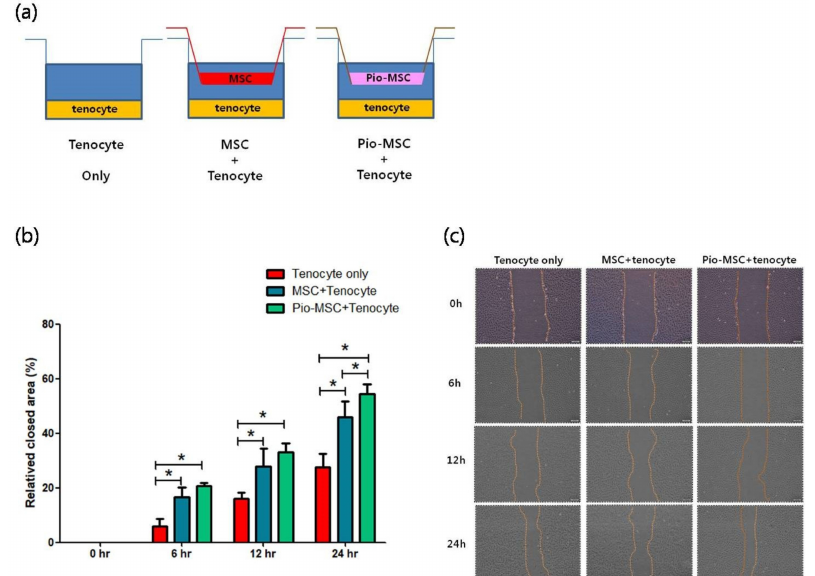
Figure 4. Migration assay of tenocytes following indirect co-culture with MSCs or Pio-MSCs. ( a ) Schematic model of the co-culture system used. Tenocytes were co-cultured with a tenocyte control, and with MSCs and pio-MSCs using transwell inserts with a 0.4- µ m porous membrane to separate the cells. Each cell type was grown independently on the transwell plates. ( b ) Relative tenocyte migration area changes following co-culture with MSCs or Pio-MSCs. The migration areas at the designated study points were normalized against that obtained at 0 h. * p < 0.05. ( c ) Light microscopy images of tenocyte migration at the designated study points. The migration area was calculated using an inherent protocol in ImageJ software. Scale bars are 200 µ